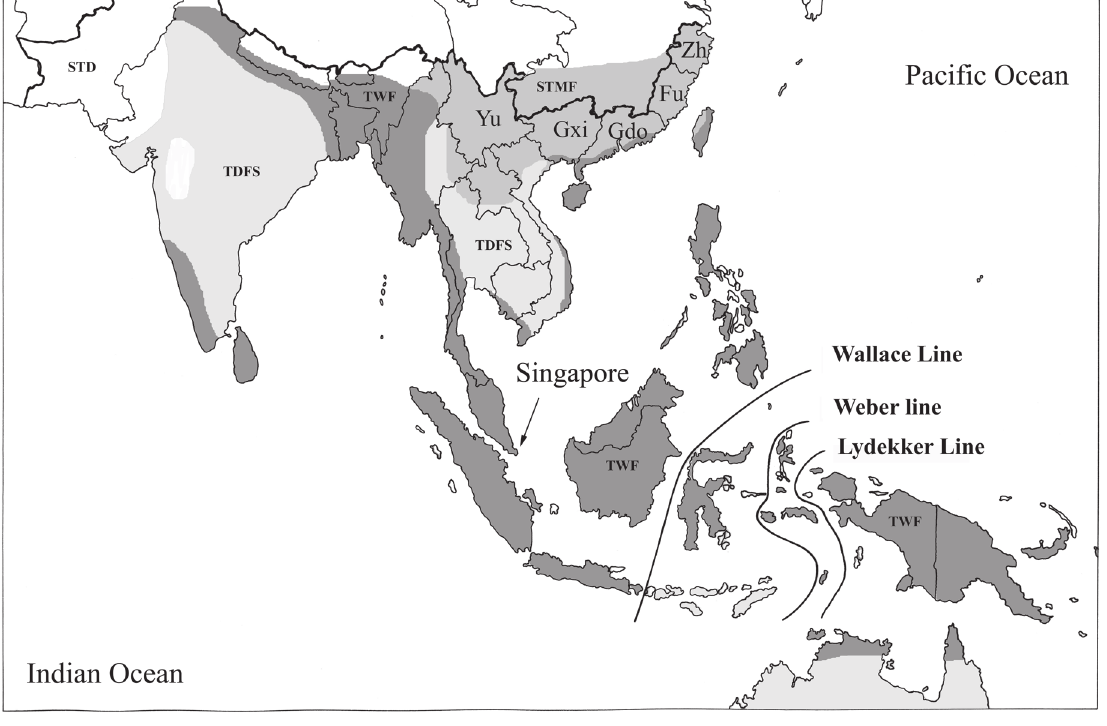
Fig. 1. Singapore in the Oriental Region (after Grootaert, 2009). STMF = subtropical mixed forest; STD = subtropical desert and semidesert; TDFS = tropical dry forest and savannah; TWF = tropical wet forest. The Weber line is considered to form the southeast boundary of the Oriental